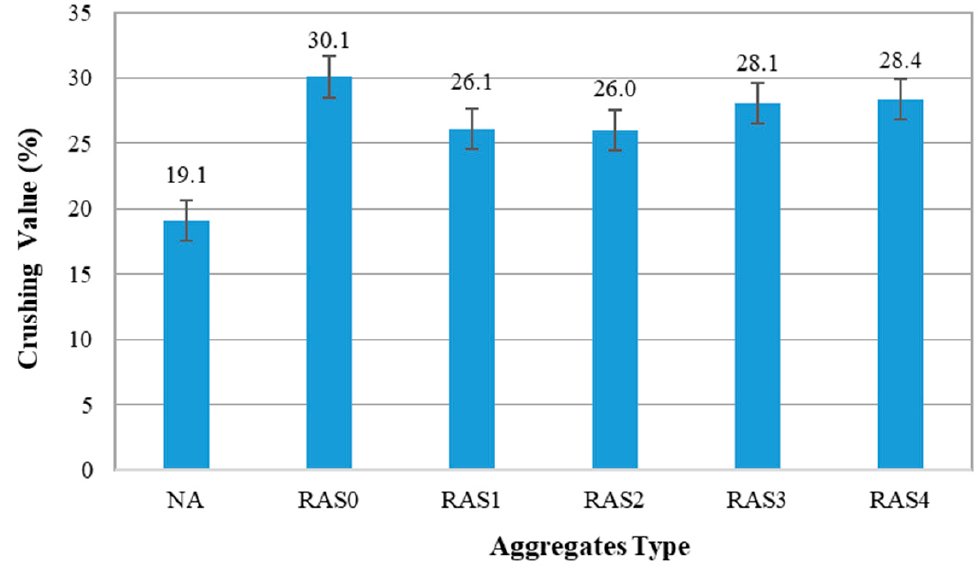
Figure 5. Crushing value of NA and RA with different numbers of screening.